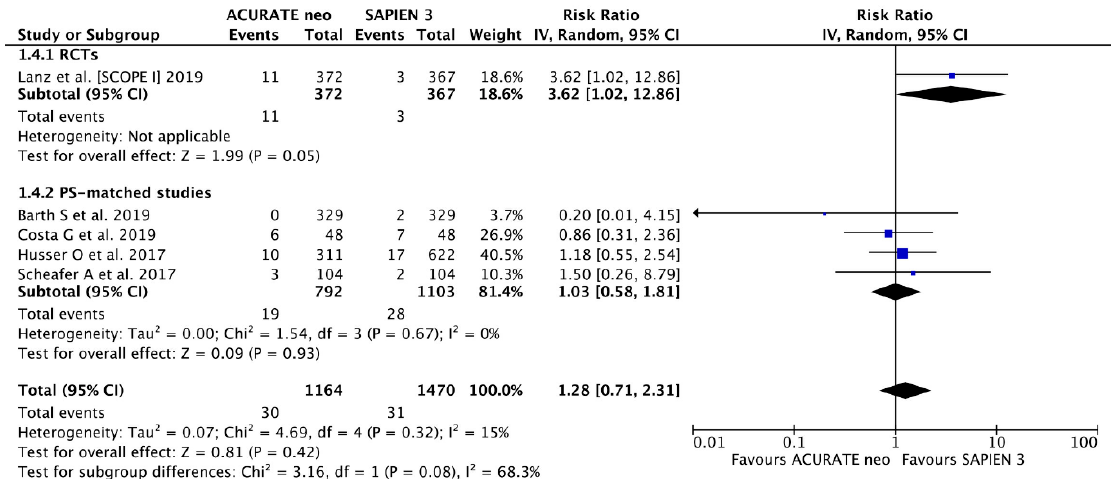
Figure A6. Clinical outcomes. Individual and summary risk ratios with corresponding 95% confidence intervals for the comparison of ACURATE neo and SAPIEN 3 in the analysis of acute kidney injury.